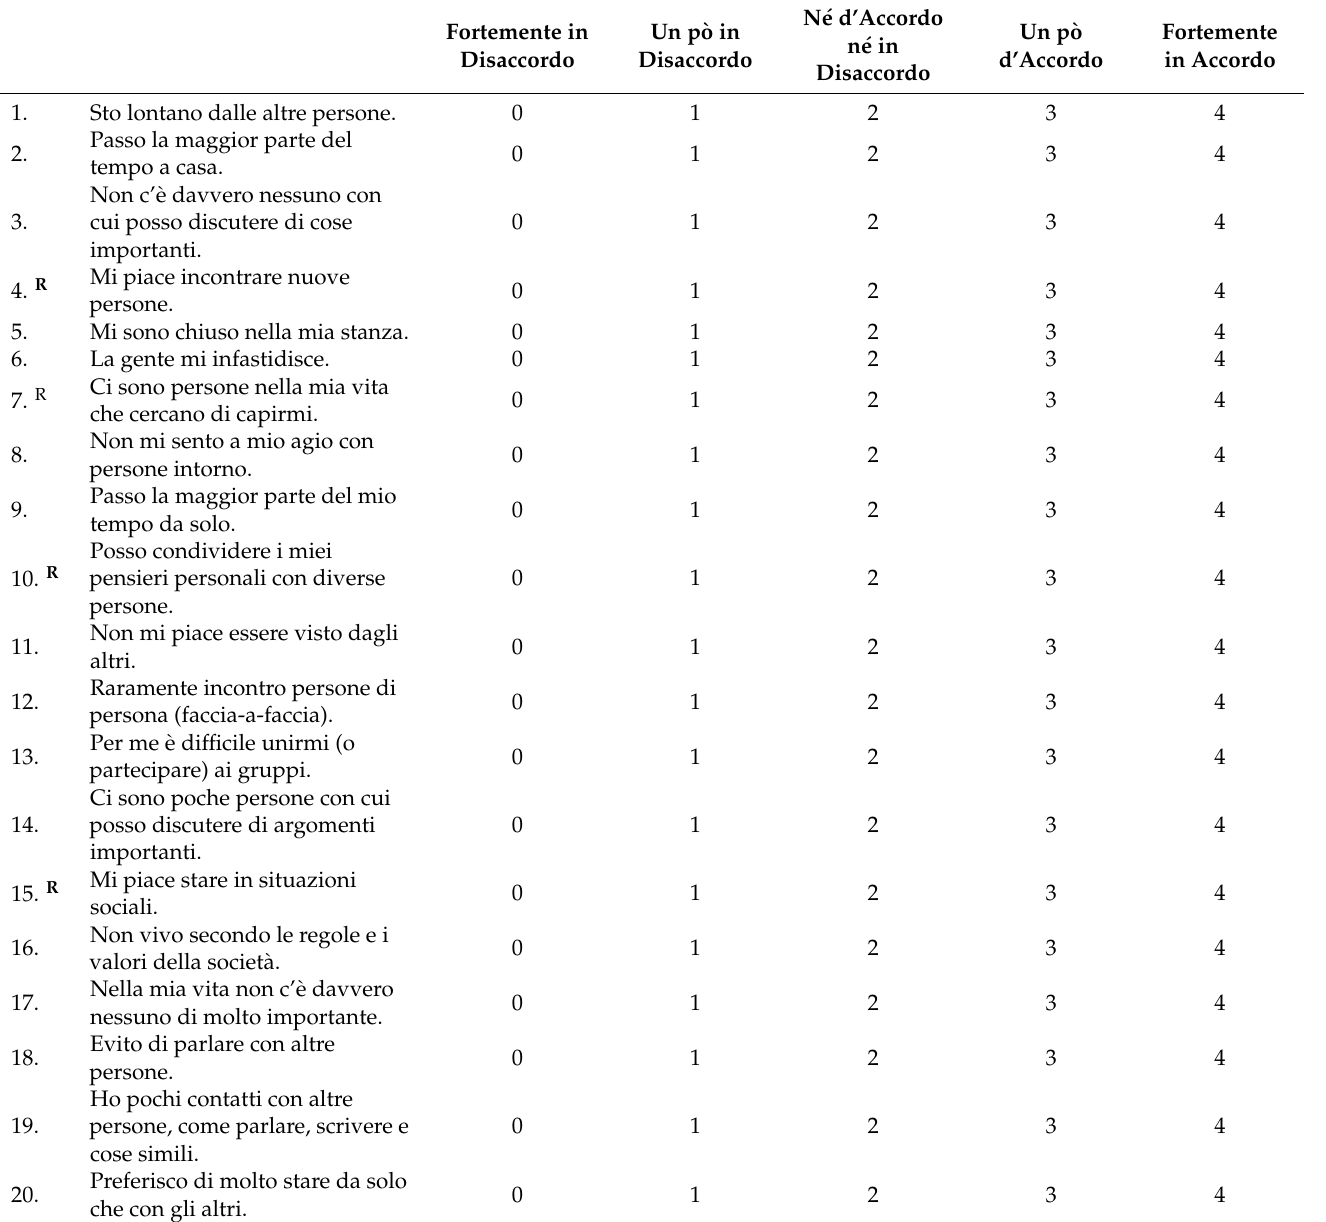
Table A1. The Italian version of the 25-item Hikikomori